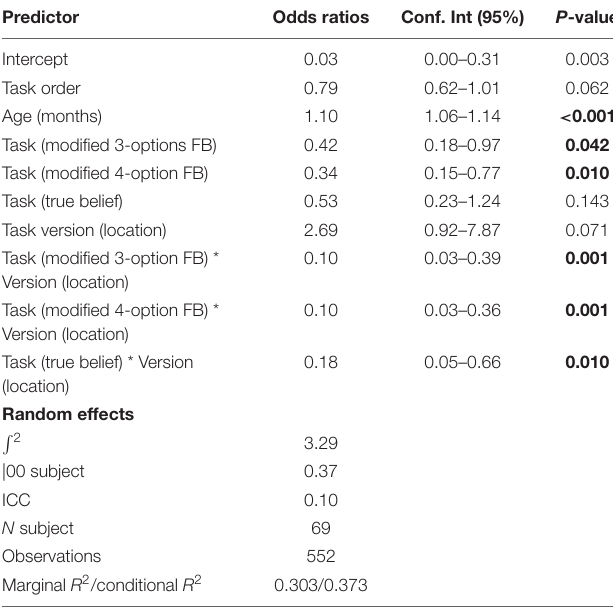
TABLE 3 | Results of mixed logistic regression model predicting odds of choosing belief by age, task order, task type, and task